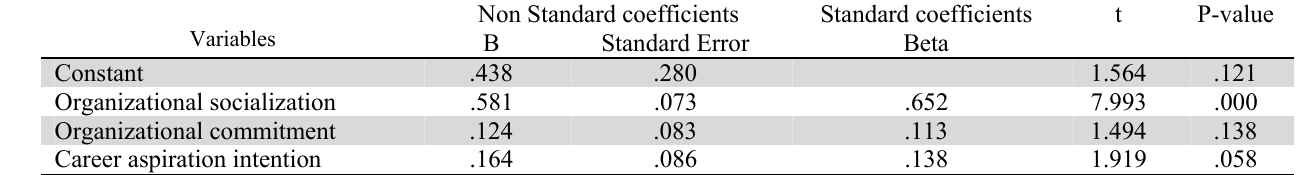
Table 3 Result of linear regression analysis of three independent variables and turnover intention Non Standard Variables